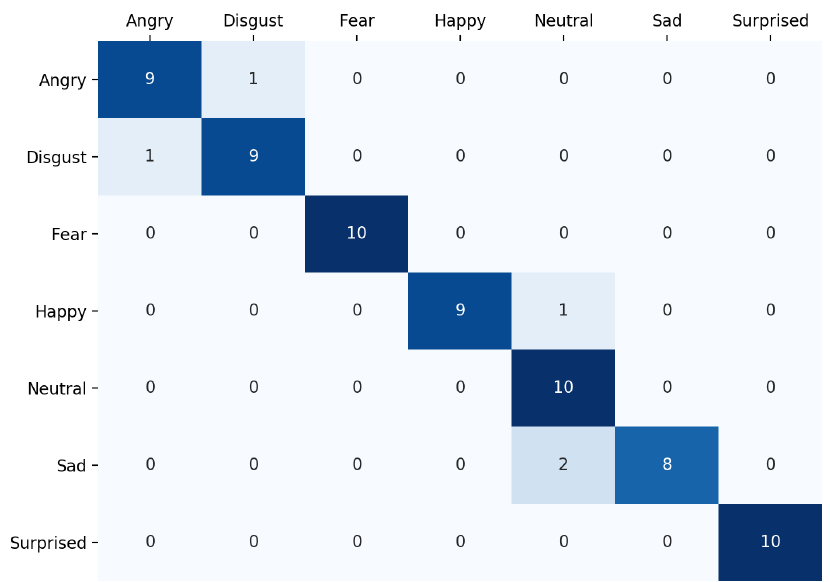
Figure 10. The confusion matrix on the JAFFE dataset. There are a total of seven emotions, and each class has 10 images in the test